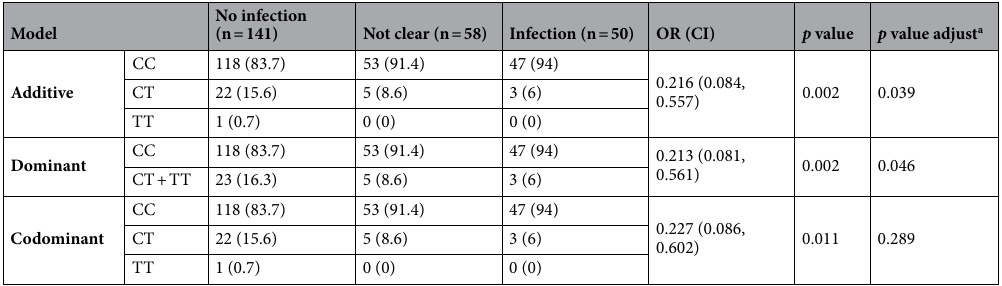
Table 2. Association of SARS-CoV-2 Infection and APOE rs7412 genotype according to genetic models. a Adjusted by sex, age, risk factors, risk of virus exposure, severity, tobacco consumption and arterial hypertension; Corrected by multiple SNP comparisons (26) by Bonferroni test.